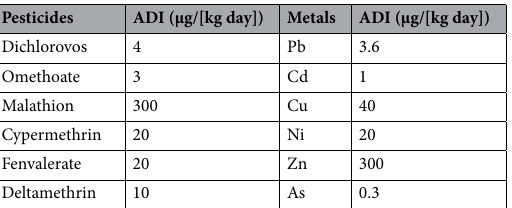
Table 6. Allowable daily intake (ADI) of pesticides and metals (μg/[kg day]). ADI of pesticides 51 . ADI of metals 52